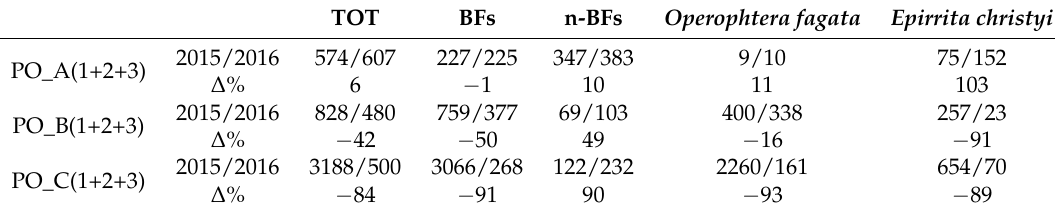
Table 1. Changes in abundance of autumn communities after the EWE in the investigated sampling sites (PO_A, PO_B, and PO_C). In detail, we reported the number of individuals collected before and after the EWE (2015/2016) and the differences between the two sampling years as a percentage ( ∆ %) regarding total community (TOT), beech feeders (BFs), non-beech feeders (n-BFs), and most impacted species ( Operophtera fagata and Epirrita christyi